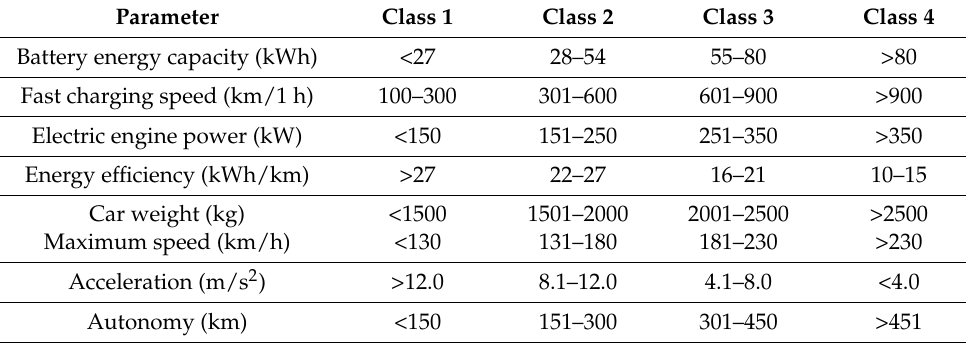
Table 3. Class-coding parameter data